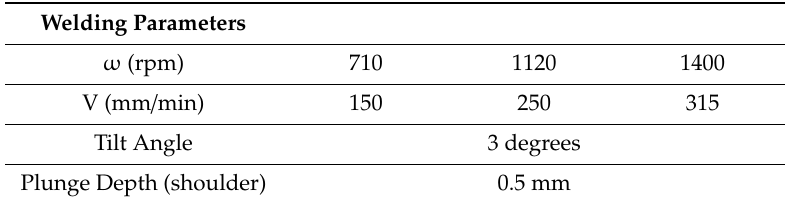
Figure 1. Configuration of the FSW tools utilized for the AA1100 weld trials (( a ) conical, ( b ) square and ( c ) threaded pin tools) with geometry and dimension. Table 2. The operational welding parameters of the friction stir welding (FSW) process for the AA1100